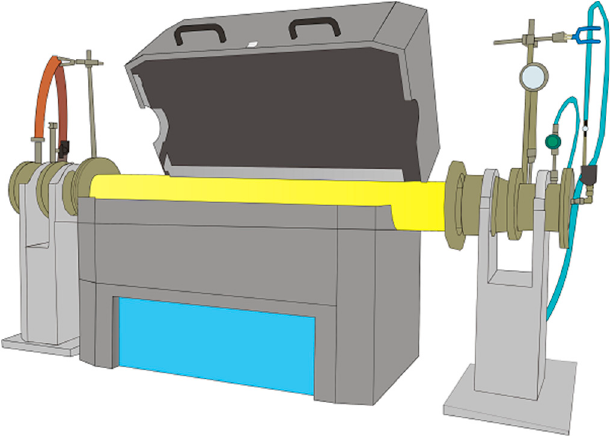
Figure 1. Schematic drawing of Chemical Vapor Deposition apparatus.